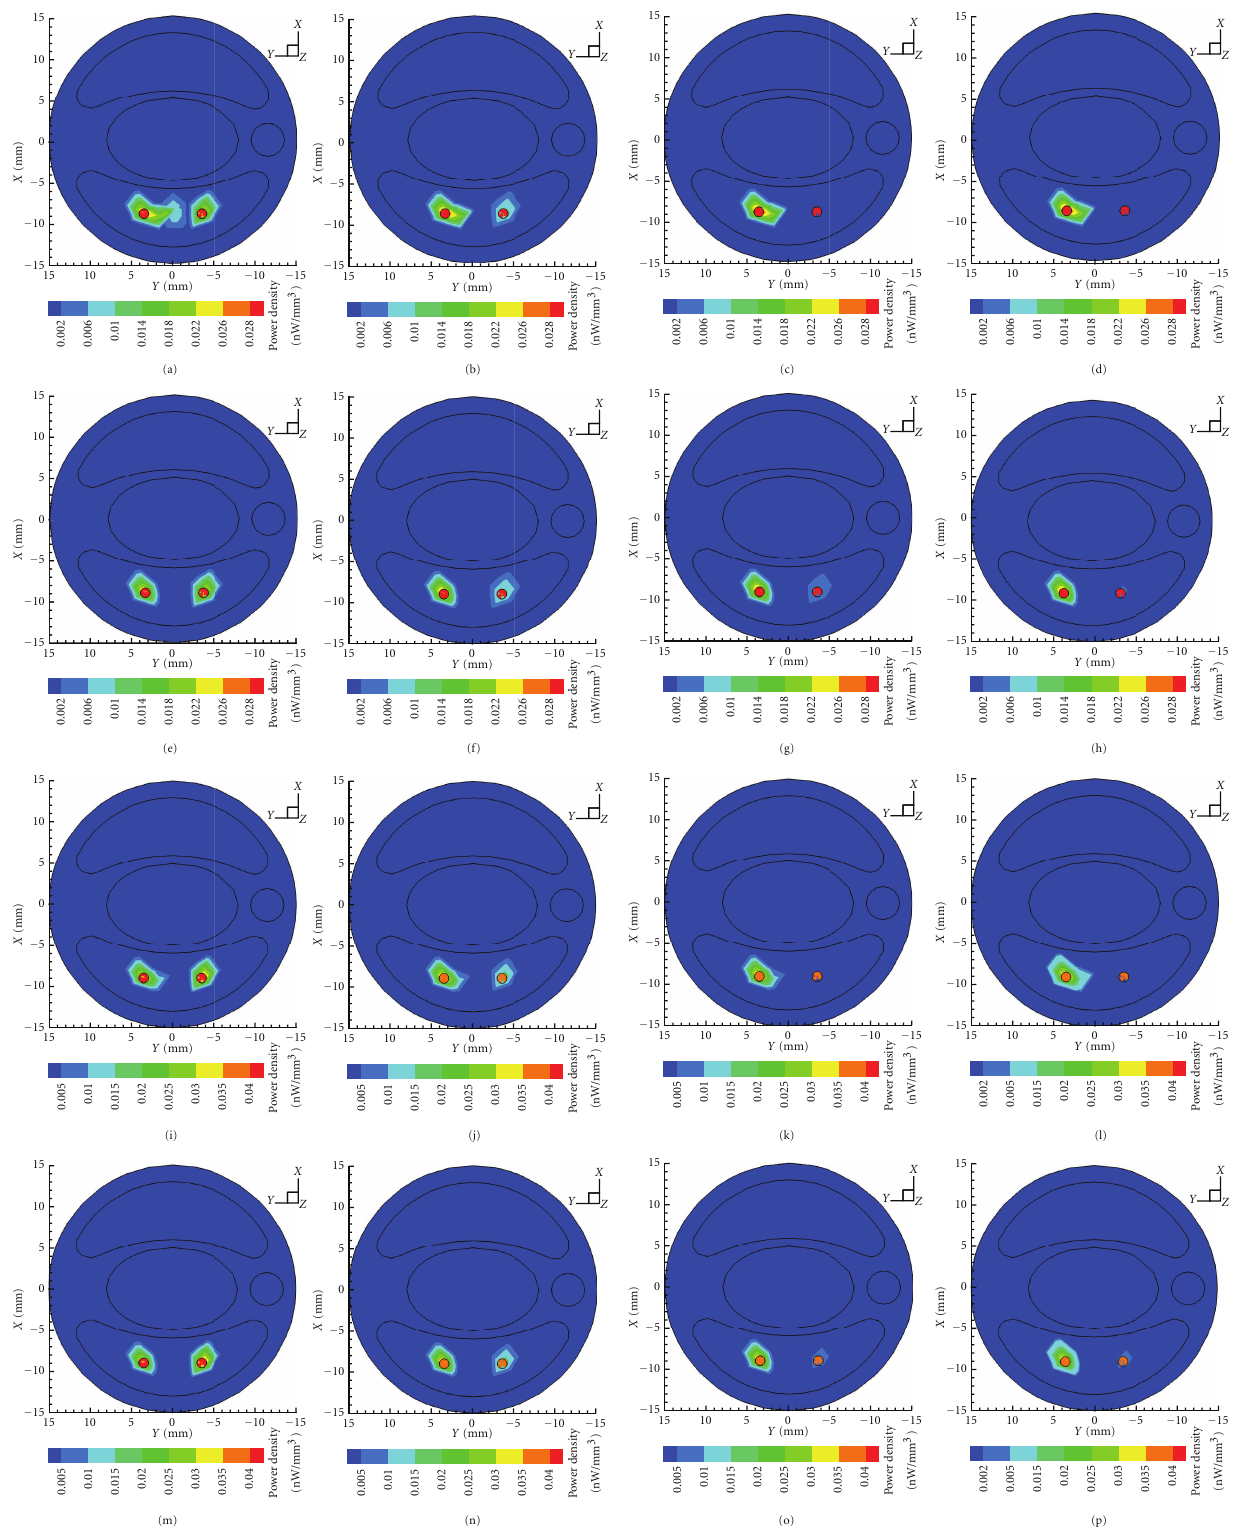
Figure 3: From left to right: transverse views of the reconstruction results at z = 15 mm in power ratio of 1 :1, 2:1, 4:1, and 8: 1. From top to bottom: final results of Tikhonov + GTS, Tikhonov + MSDS, l 1– ls + GTS, and l 1– ls + MSDS,